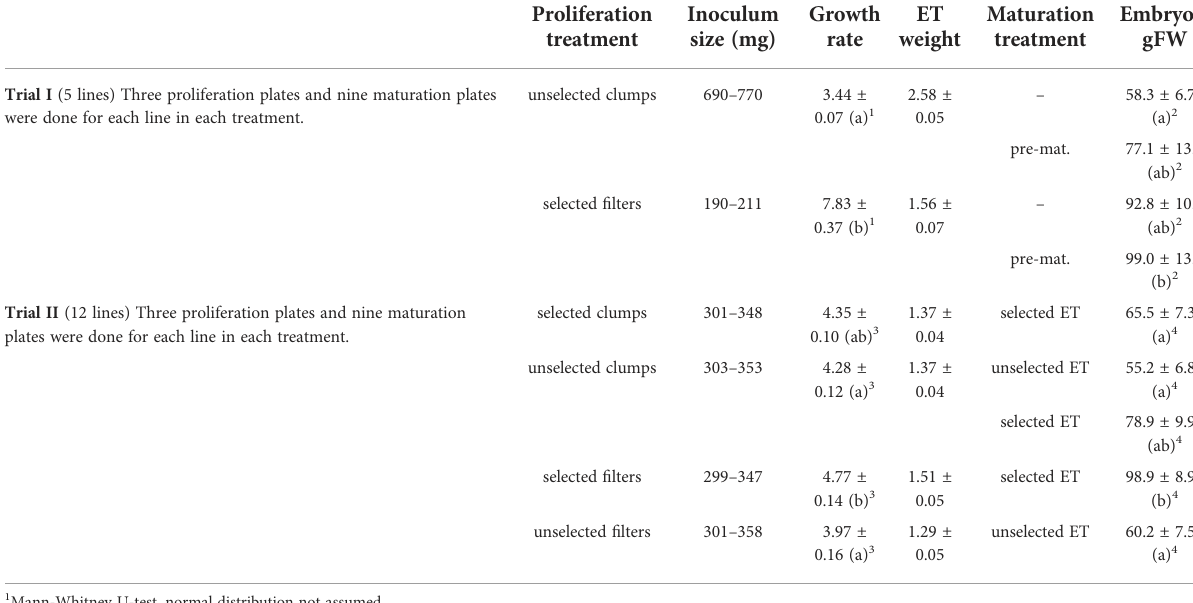
TABLE 2 Proliferation and maturation results from Trials I and